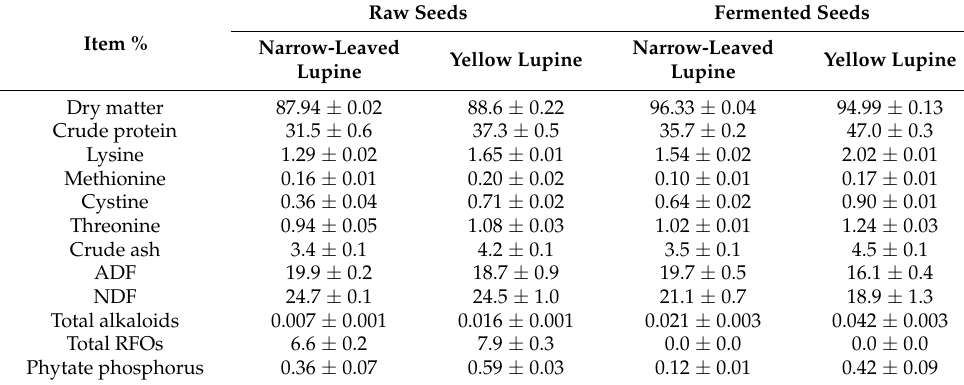
Table 1. The chemical composition of raw and fermented lupine seeds.